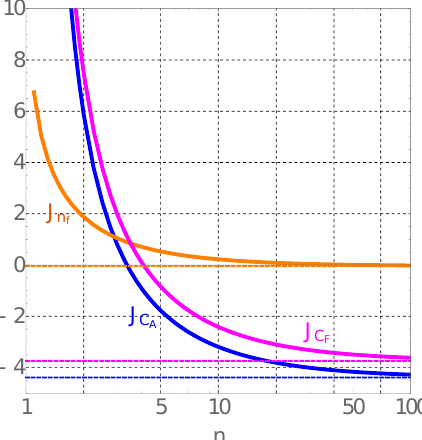
) jet function for the recombination scheme in eq. (4.20) with n > 1 . F